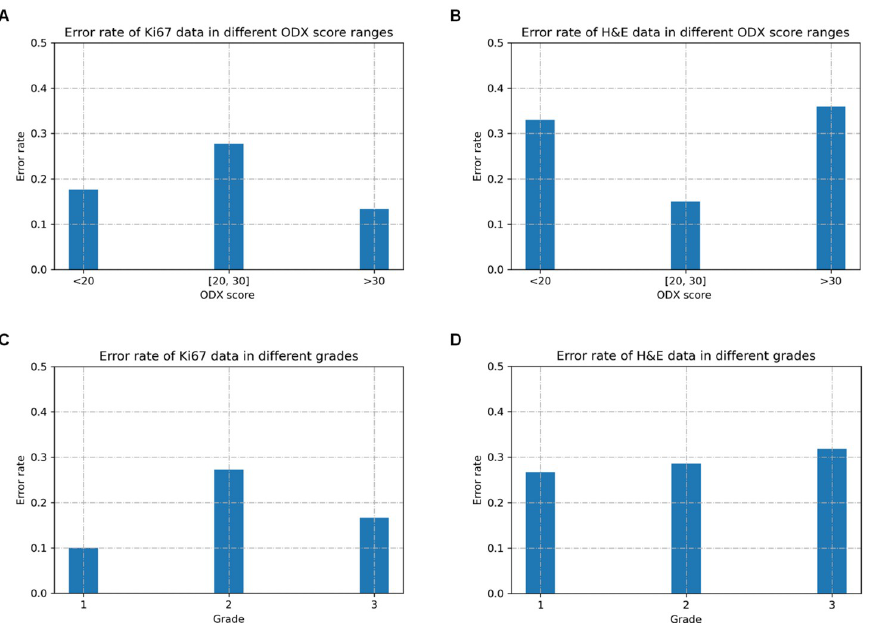
Fig 12. BCR-Net’s validation error rate for patients in different ODX score ranges and grades. The error rate in a particular group is calculated by dividing the number of misclassified cases in that group by the total number of cases in that group during cross-validation. (a) Error rate resulting from using Ki67 data in different ODX score ranges. (b) Error rate resulting from using H&E data in different ODX score ranges. (c) Error rate resulting from using Ki67 data in different grades. (d) Error rate resulting from using H&E data in different